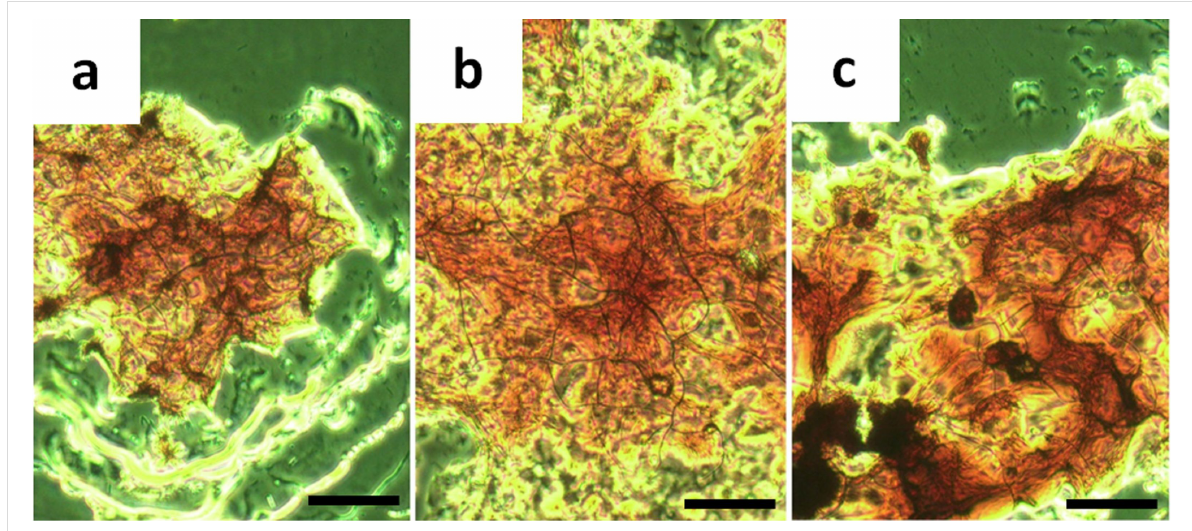
Figure 5: Optical micrographs (20 × 20) of CT xerogels ( 3 and 4 , 1:1, molar ratio, [ 3 ] = 9 mM) in (a) DMSO/water (3:1, v/v), (b) ethylene glycol, and (c) DMF/water (3:1, v/v). Scale bar is in 0.1 mm.